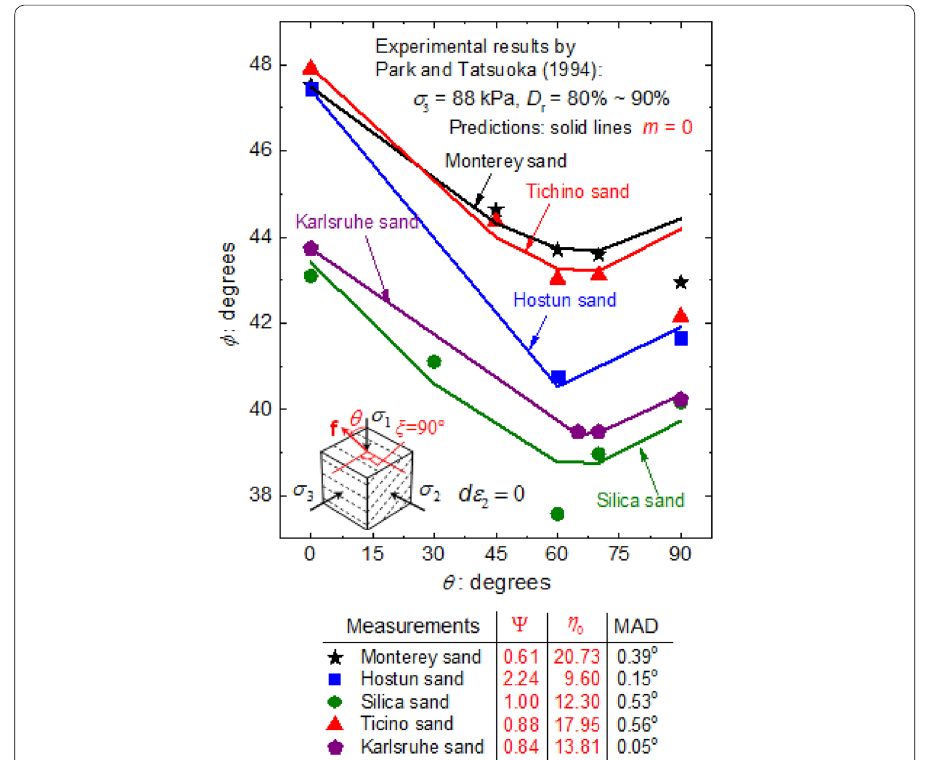
Fig. 19 Comparison between plane strain compression test results of five sands by Park and Tatsuoka [36] and predictions by this study